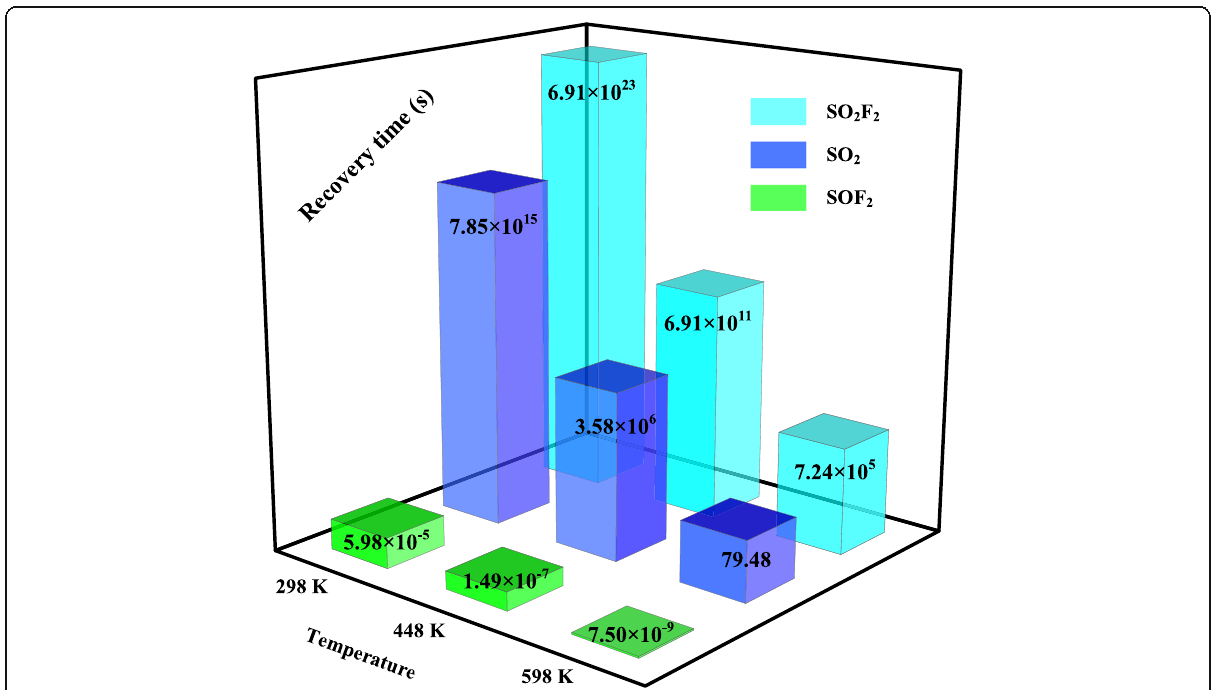
Fig. 8 Recovery time of Rh-MoTe 2 monolayer at various